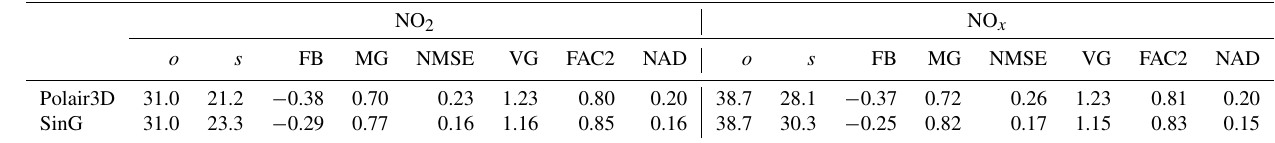
Table 5. Statistical parameters ∗ at background stations ( o and s represent the average observed and simulated concentrations, respectively; µgm − 3 ).